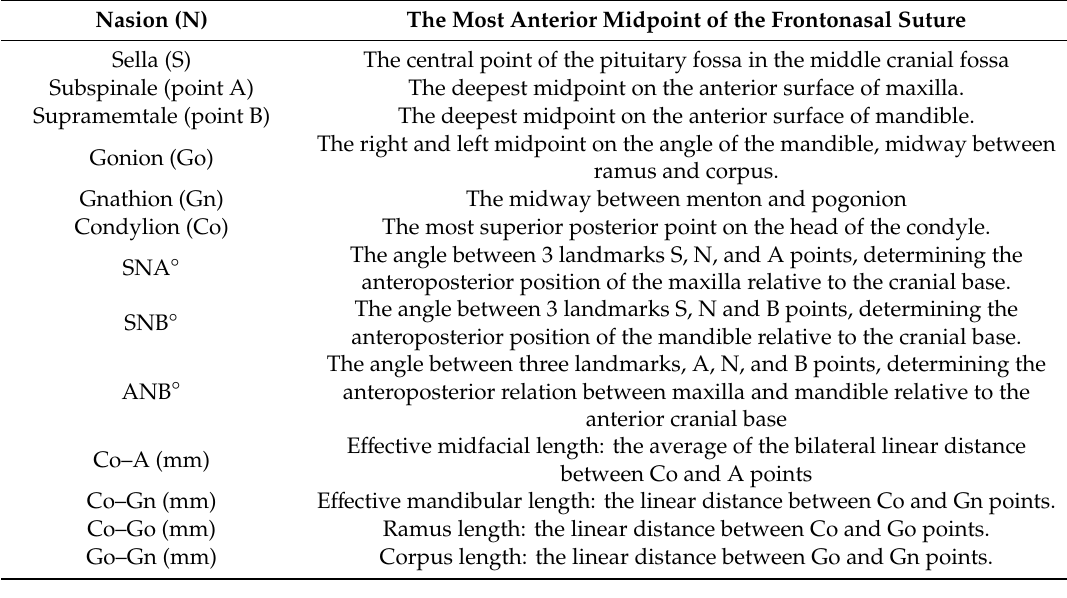
Table 1. Cephalometric reference landmarks and sagittal measurements used in the study.